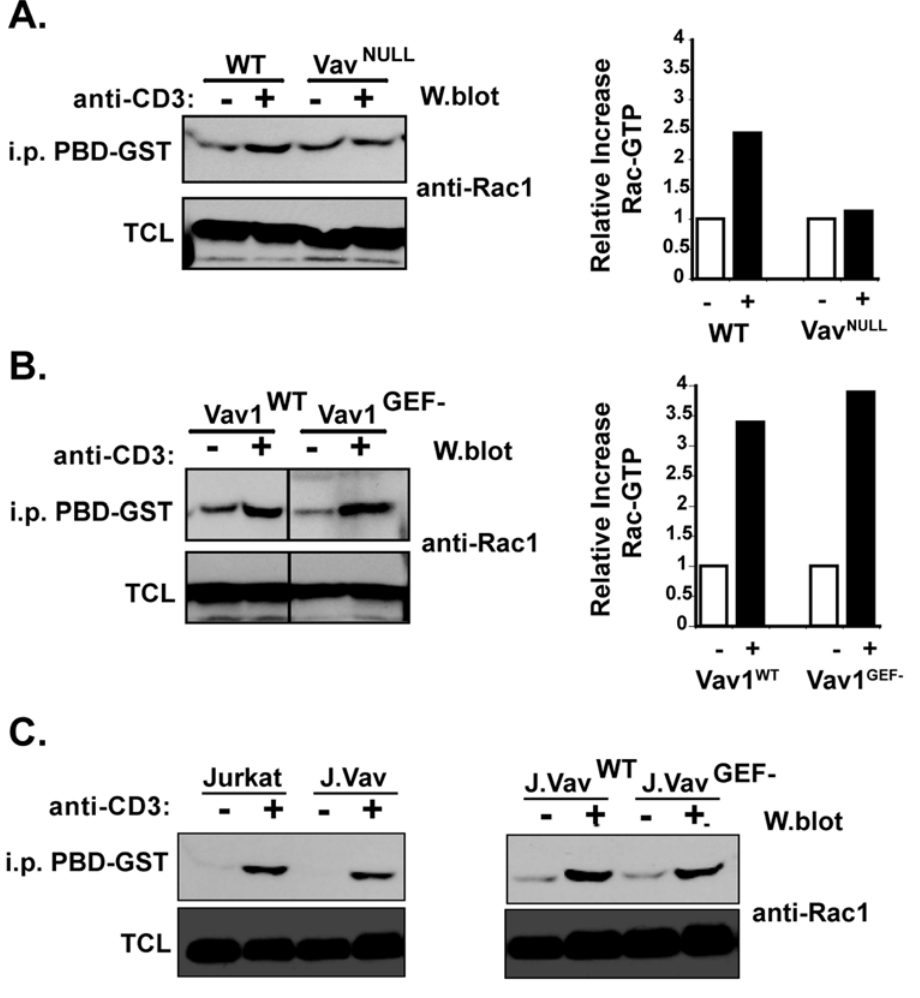
Figure 6. Expession of Vav1 GEF 2 restores TCR-induced Rac1 activation. (A) Rac1 activation in WT and Vav NULL T cells stimulated with anti- CD3 antibodies. The graph represents relative increase in Rac1-GTP. (B) Rac1 activation in Vav1 WT and Vav1 GEF 2 T cells stimulated with anti-CD3 antibodies, n=2. The graph represents relative increase in Rac1-GTP. (C) Rac1 activation in Jurkat, J.Vav, J.Vav reconstituted with WT Vav1 (J.Vav WT ), and J.Vav reconstituted with GEF-deficient Vav1 (J.Vav GEF 2 ). TCL=total cell lysate.